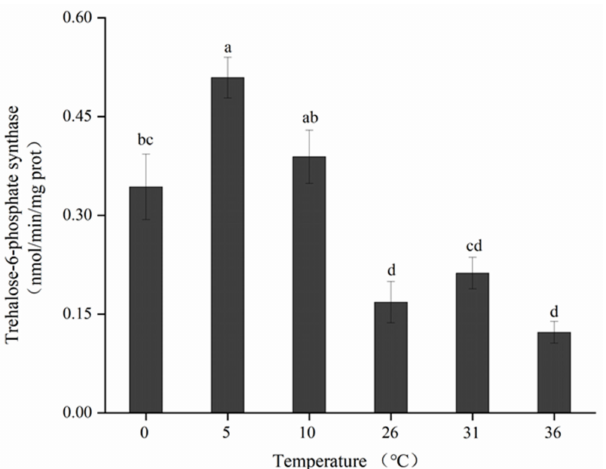
Figure 6. Trehalose-6-phosphate synthase activity of adult B. dorsalis exposed to various high- and low-temperature treatments. Different lowercase letters indicate significant differences ( p < 0.05, Tukey’s test). Data are expressed as means ± standard errors of five